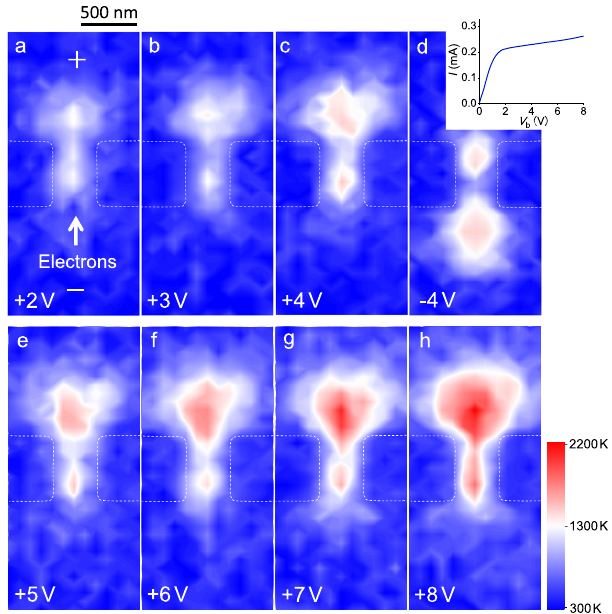
Fig. 2 Evolution of the two- T e -peak structure in the real-space hot- electron distribution with increasing bias voltage, V b . a – h 2D images of T e obtained with SNoiM, where d shows the image in the opposite bias polarity. The device studied is similar to that for Fig. 1, with a slightly different geometry of the constriction channel of 450 nm width and 640 nm length. White dotted lines are guides for the eyes to show the mesa edges that de fi ne the constriction. The current – voltage trend is shown in the